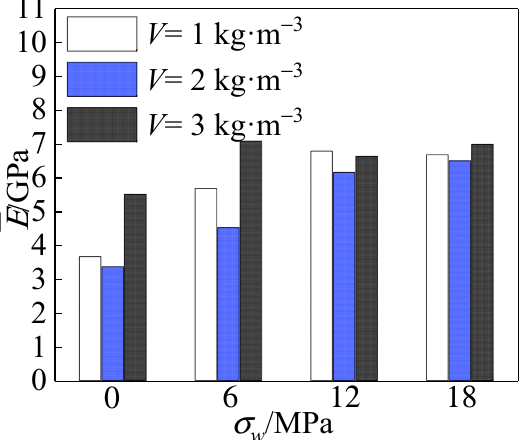
Figure 23. Effect of polypropylene fiber admixture on elastic modulus.